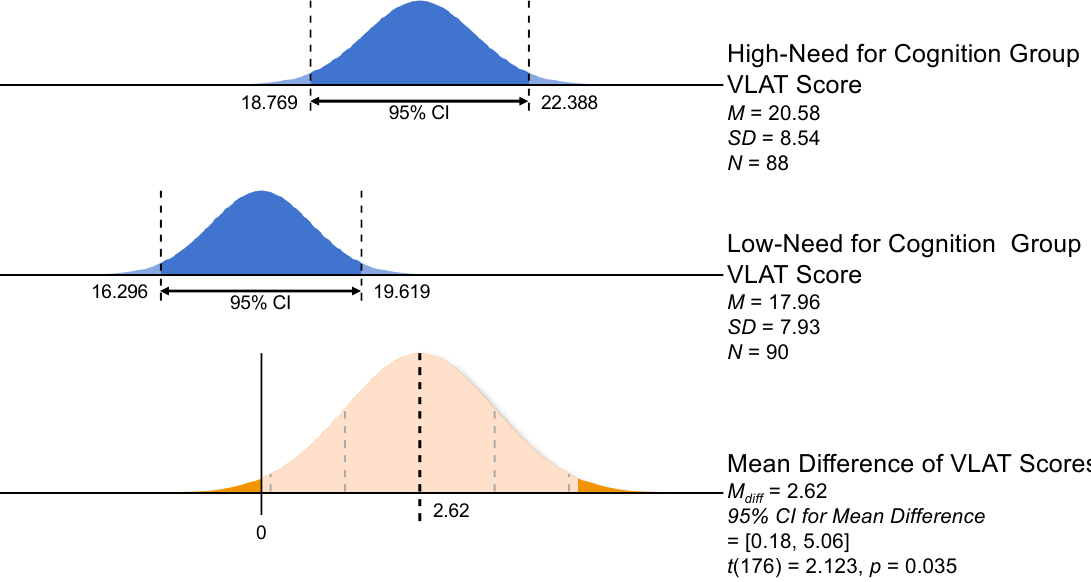
Figure 4. Difference in VLAT scores between high-need-for-cognition user group and low-need-for-cognition user